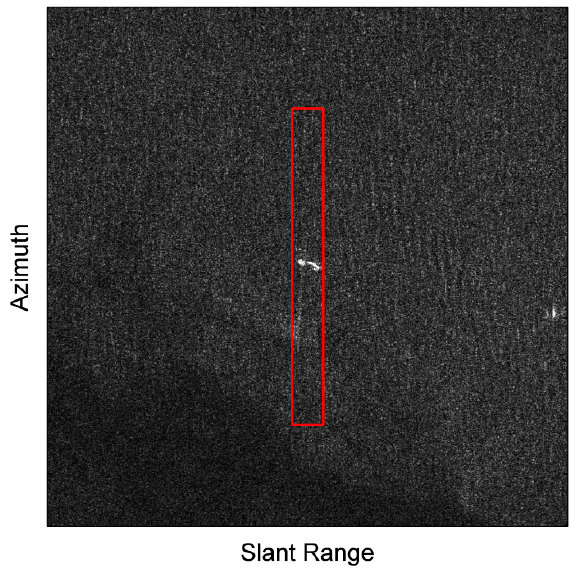
Figure 7. Ship not related to wake. COSMO/SkyMed image on 23 June 2012 (Table 3).